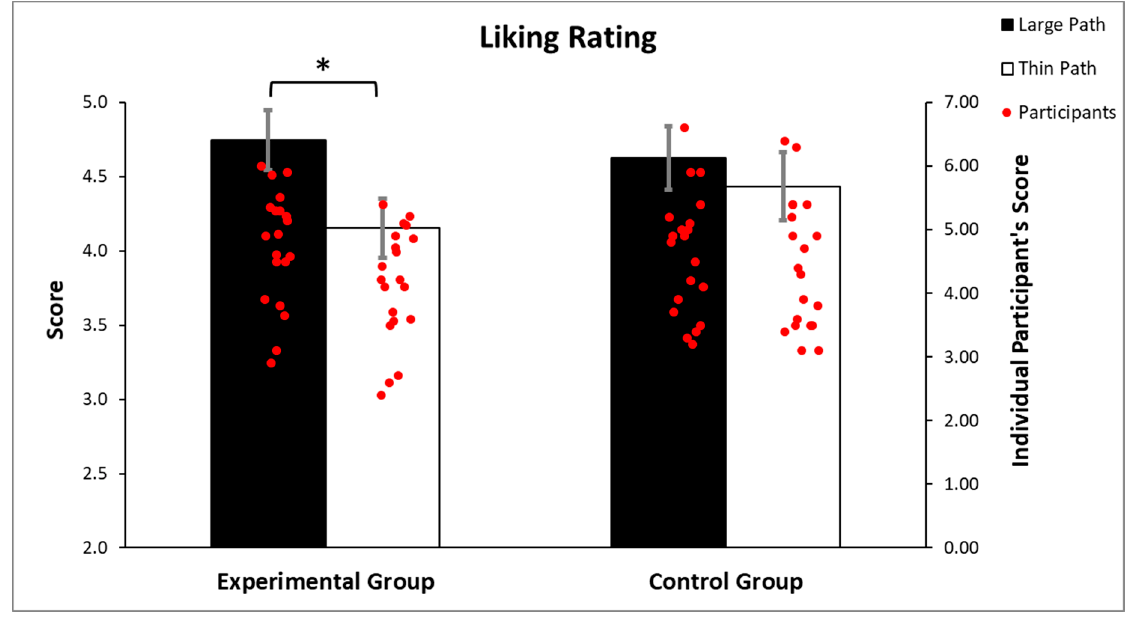
Figure 3. Analysis of the liking scores illustrates that the liking ratings were influenced by the path widths only in the experimental group ( p < 0.001). Vertical lines indicate the standard error of mean (SEM), * p < 0.05.